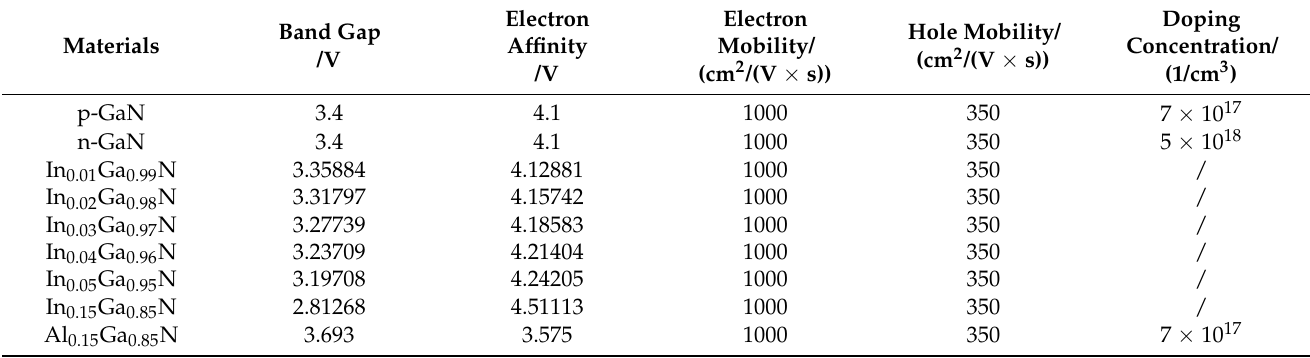
Table 1. Nano-LED epitaxial structure parameters.